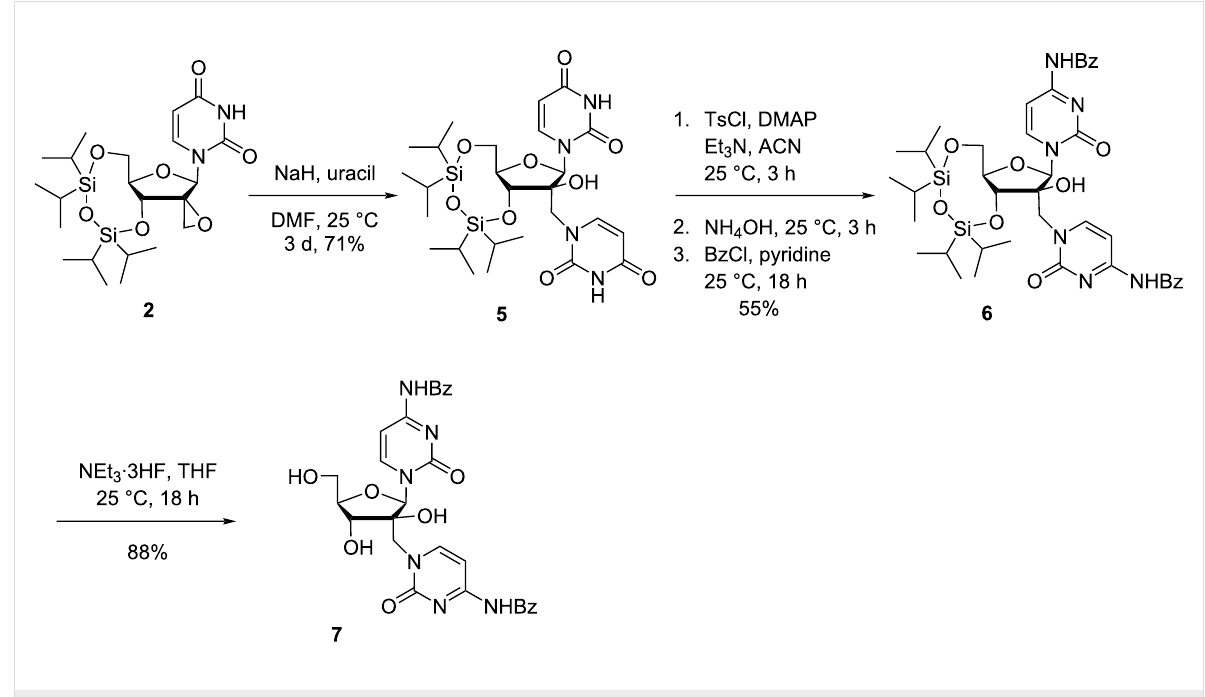
Scheme 2: Synthesis of double-headed nucleoside 7 having two cytosine moieties.